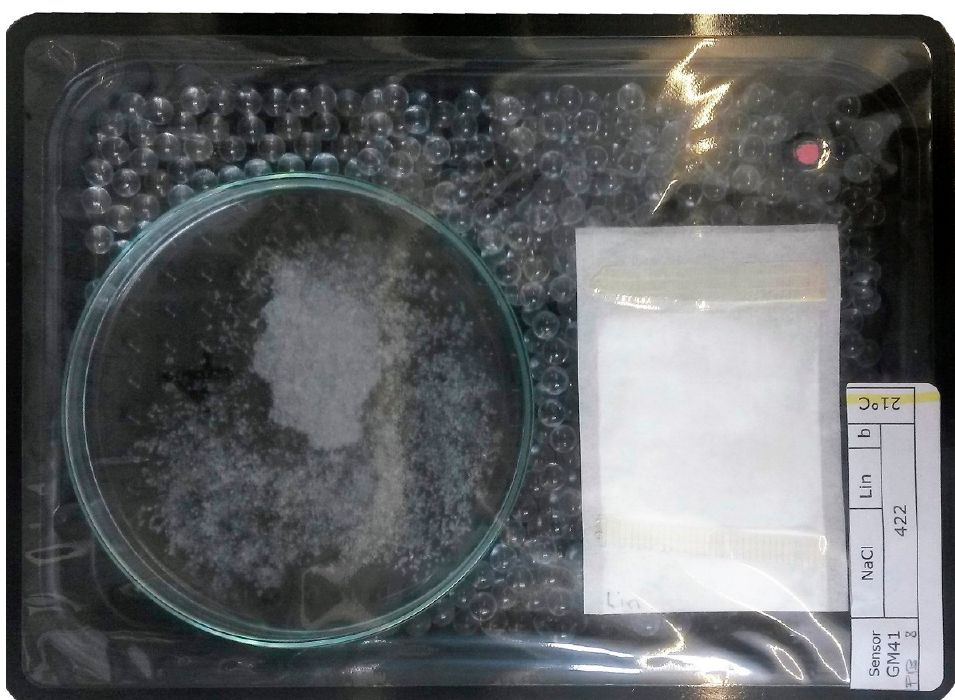
Figure 1. Example package setting for oxygen scavenging measurements. High barrier tray containing 1 g modified calcium carbonate (MCC) powder loaded with UFAs in a sealable teabag fixed on the lidding film, a petri dish filled with a saturated salt solution, glass beads to adjust the headspace volume and an oxygen sensitive sensor spot (red).